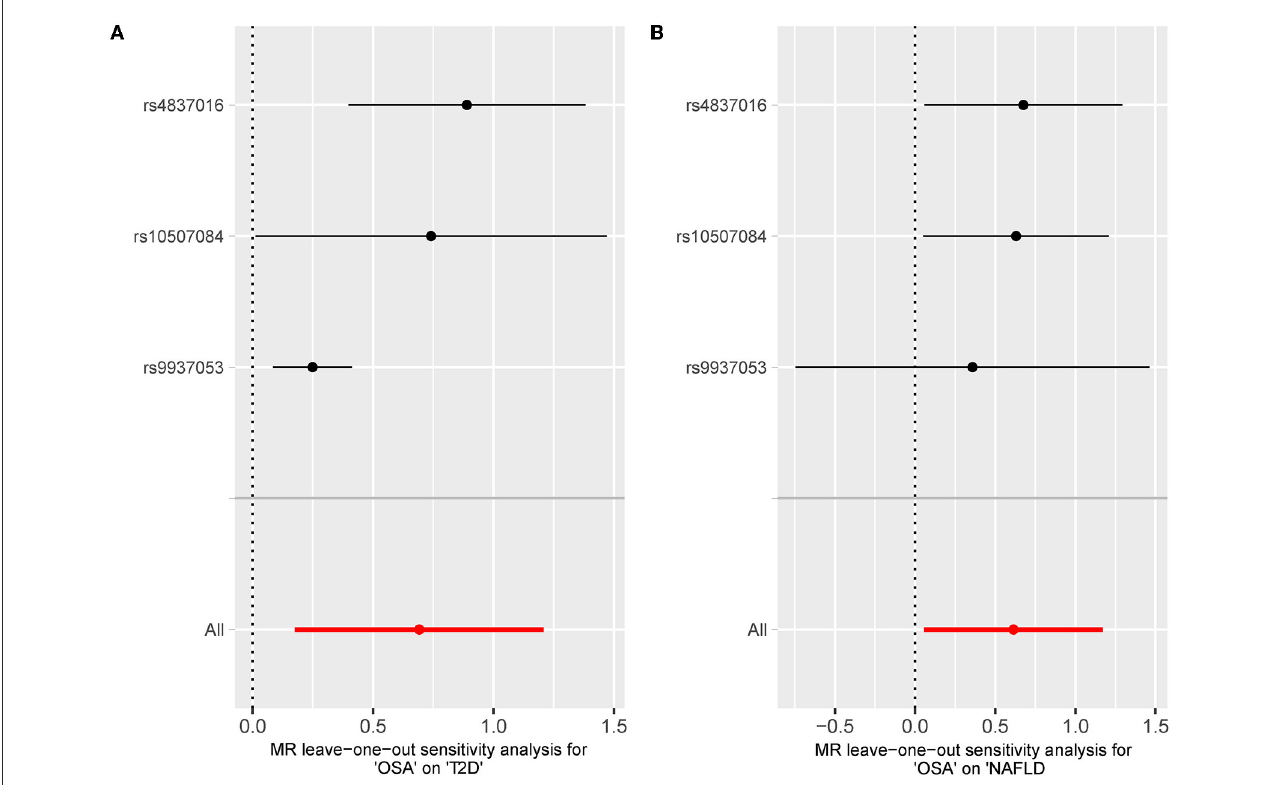
FIGURE7 (A) The leave-one-out-sensitivity forest plot of OSA-T2D results after removal of SNP rs10928560. (B) The leave-one-out-sensitivity forest plot of OSA-NAFLD results after removal of SNP